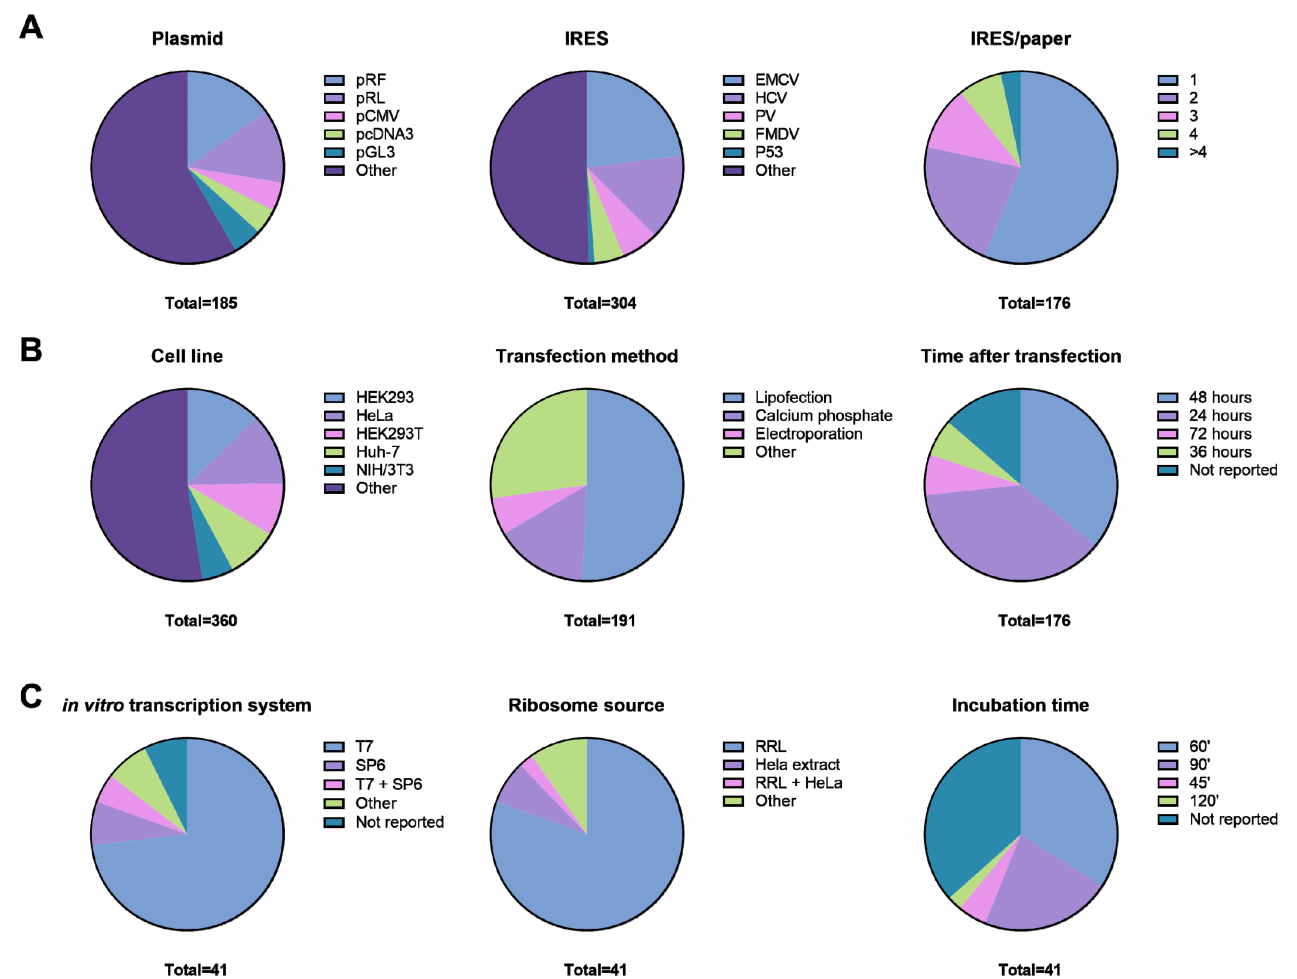
Figure 3. An overview of extracted information from included studies. ( A ) Plasmid, IRES, and the number of IRESs/ publication were quantified and depicted in pie charts. ( B ) Cellular translation assay parameters. Transfection methods were combined in four categories for easier visualization. Time of transfection refers to the measurement time point of the reporter post-transfection. ( C ) Cell-free translation assay parameters. Note: total numbers do not always match the number of included studies due to the use of multiple parameters in one